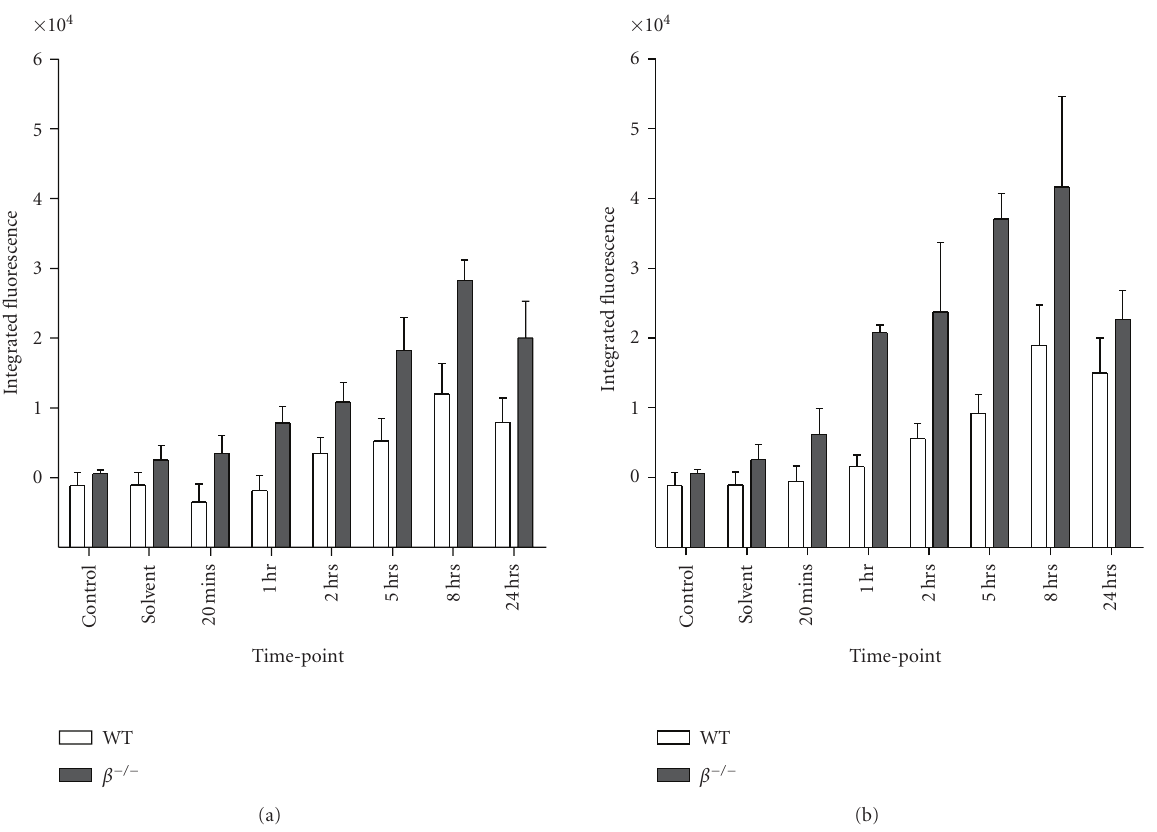
Figure 5: TARDIS analysis of cells treated with etoposide continuously for 24 hours. Topoisomerase II-DNA adducts were detected using an antibody that detects both isoforms in WT and TOP2 β − / − MEFs following exposure to 1 μ M (a) or 10 μ M (b). Plots show the mean of the median FITC fluorescence from at least three independent